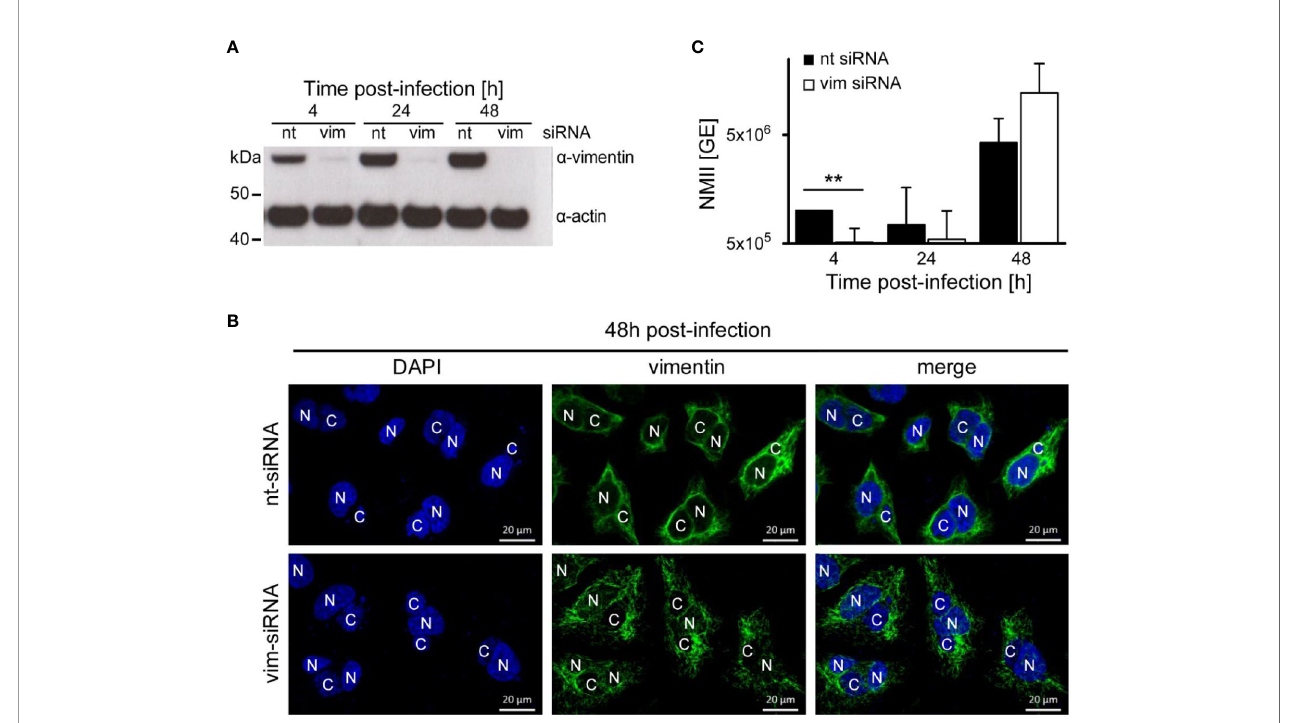
FIGURE 9 | Vimentin is dispensable for C. burnetii replication. (A – C) HeLa cells were transfected with 50 nM non-targeting (nt) or vimentin-targeting (vim) siRNA. After 24 h post-transfection, cells were infected with C. burnetii (WT) at a MOI of 50. (A) At the time points post-infection indicated, total cell lysates were separated by SDS-PAGE and analyzed by immunoblot analysis using antibodies against vimentin and actin as loading control. The immune blot is representative of four independent experiments. (B) 48 h post-infection, cells were fi xed and stained with an anti-vimentin antibody (green). Nuclei and bacterial DNA were stained with DAPI (blue). Images are representative of two independent experiments. N: nucleus, C: C. burnetii -containing vacuole. (C) At the time-points indicated, cell lysates were prepared by osmotic lysis. Bacteria, isolated by differential centrifugation, were used for preparation of genomic DNA (gDNA). Absolute quanti fi cation of bacterial genomic equivalents was performed by quantitative real-time PCR with primers speci fi c for genomic IS1111 sequences. gDNA, prepared from axenically- grown C. burnetii cultures served as standard for genomic equivalents. Error bars represent mean standard deviations of four independent experiments. ** p <